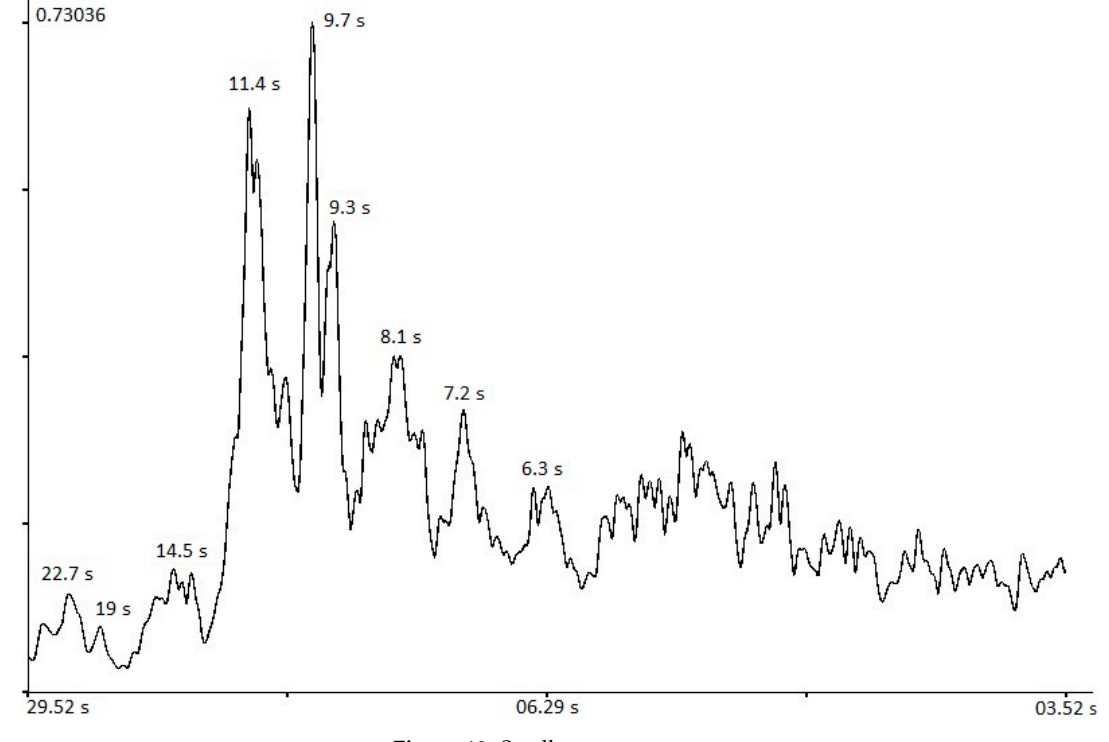
Figure 10. Swell waves spectrum.